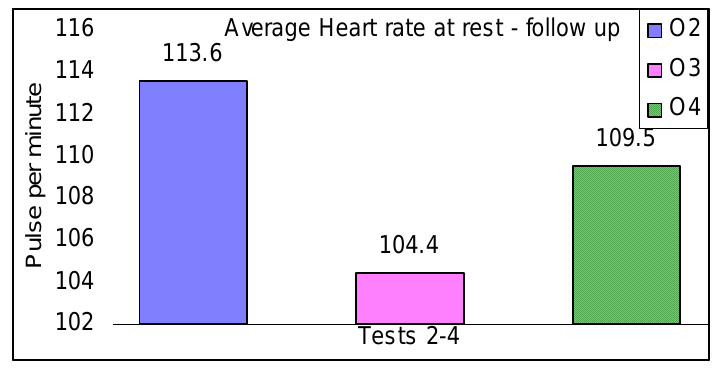
FIGURE 5 . A change in heart rate a year after intervention terminated. The figure represents the average heart-at-rest scores for all participants still at daycare center (n = 11) at O 2 (at the beginning of the intervention program), O 3 (at the end of the 2- month intervention program), and O 4 (a year after intervention